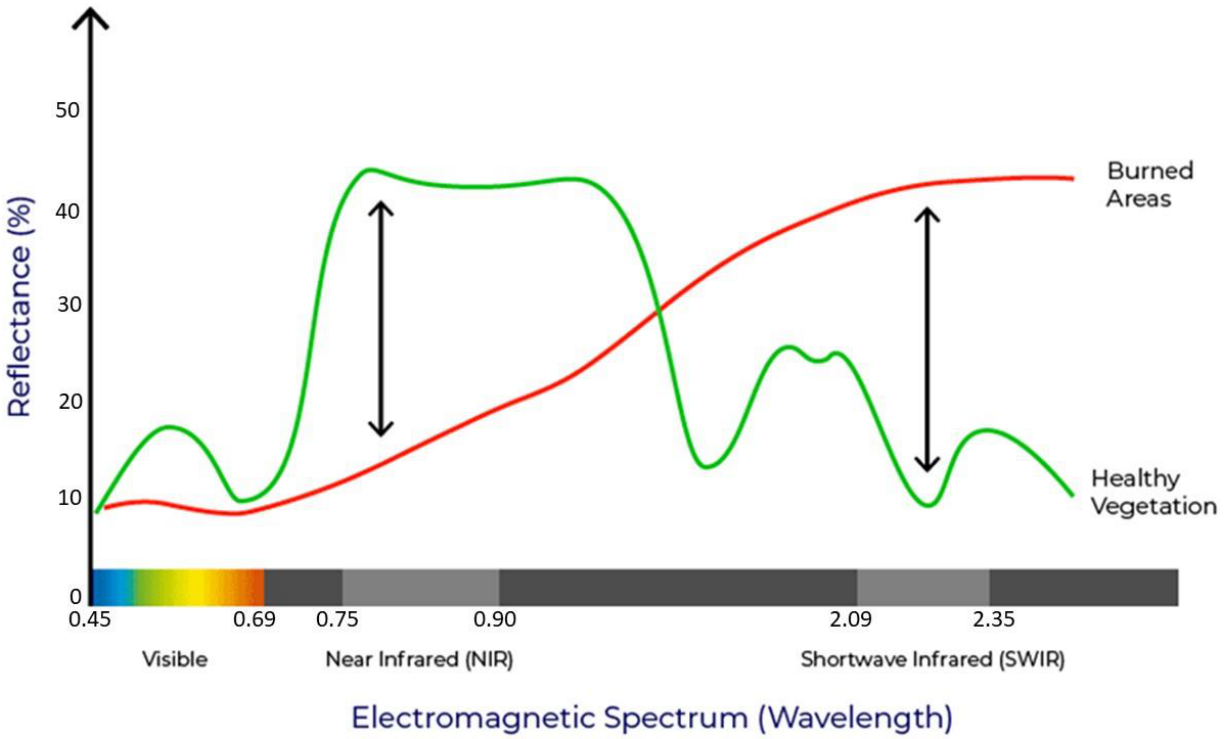
Figure 4. Comparison of the spectral response of healthy vegetation and burned areas (Source: USDA Forest Service).